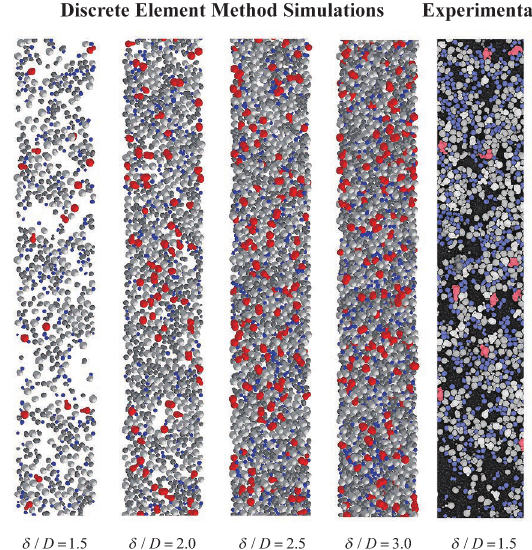
Fig. 1 Discrete Element Method simulation and experimental validation of spreading of gas-atomised metal powders by a blade, showing empty patches and size segrega- tion in the spread layer as a function of spreader gap height. Narrow gaps cause transient jamming, as evi- dent by empty patches. The frequency of formation and size of empty patches can also be inferred, as shown in Fig. 2 . The particles are coloured based on their pro- jected area equivalent circle diameter, blue (15–25 μm), dark grey (25–35 μm), light grey (35–45 μm), and red (45–55 μm). The number density of the largest particles (shown in red) is the lowest for the smallest gap, as predicted by Nan et al. (2018). The simulation results are for four gap heights and the experimental one is a scanning electron micrograph for the smallest gap, courtesy of Mr M.T. Hussein. Gap heights are nor- malised with respect to the characteristic particle size below which 90 % of particles by number lie ( D 90 ).